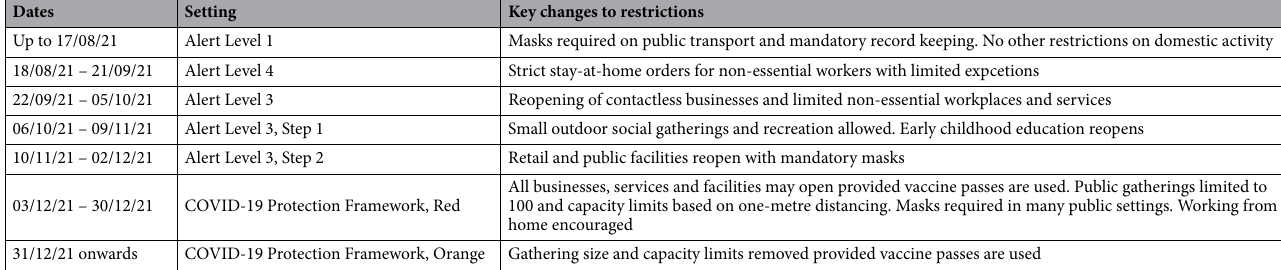
Table 1. Summary timeline of key restrictions and public health measures in response to the outbreak of the B.1.617.2 (Delta) variant in Auckland from August 2021. Other parts of New Zealand were subject to